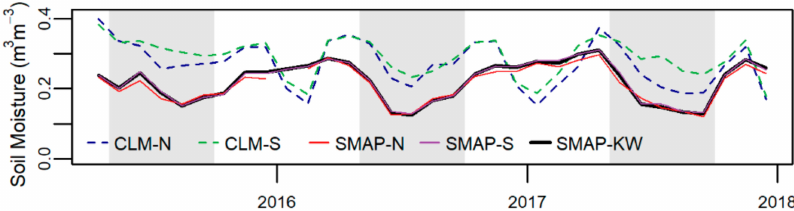
Figure 8. Comparing soil moisture from the SMAP satellite, which measures the top 5 cm of soil, to the top two layers of CLM soil (6 cm). SMAP launched in early 2015, so data is only available from March 2015, onward. Gray boxes highlight the approximate growing season—May to